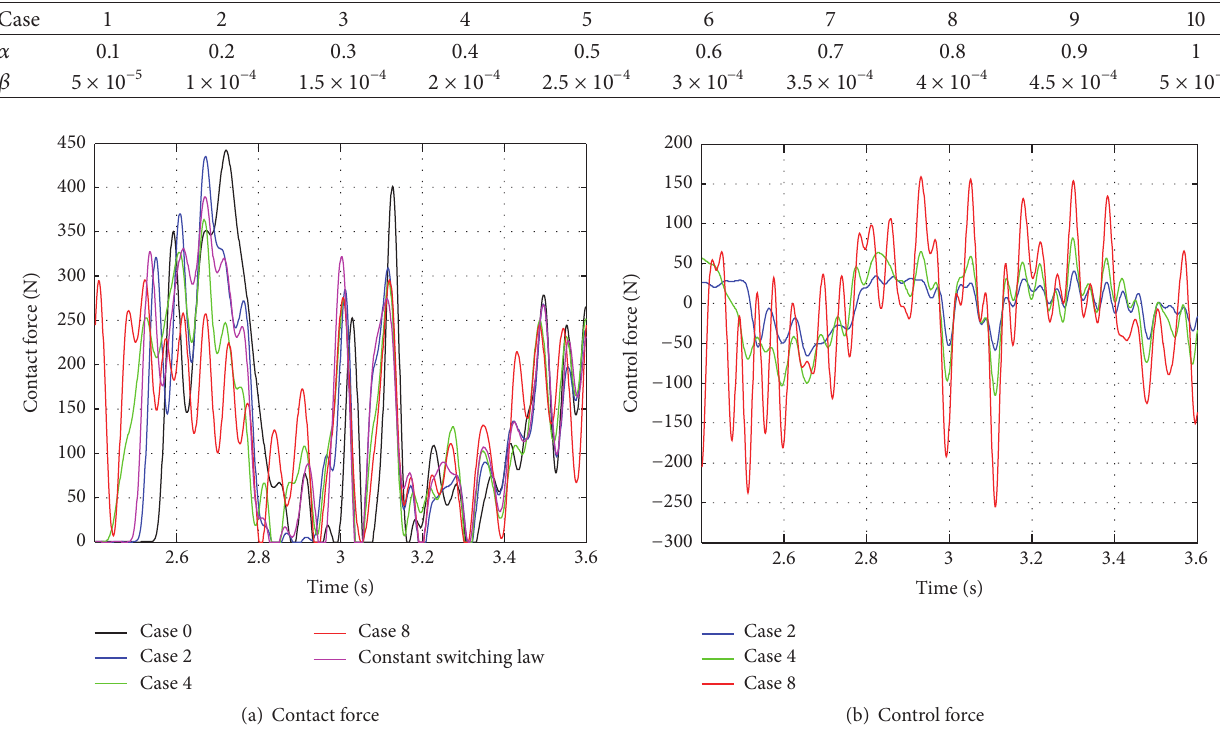
Table 3: 10 sets of control gains.